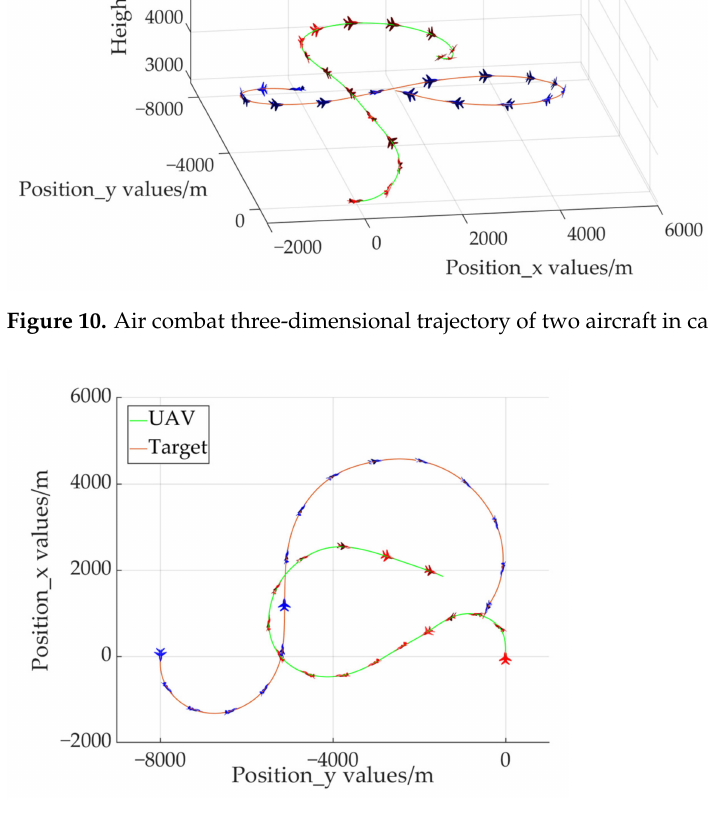
Figure 11. Air combat plane trajectory of two aircraft in case